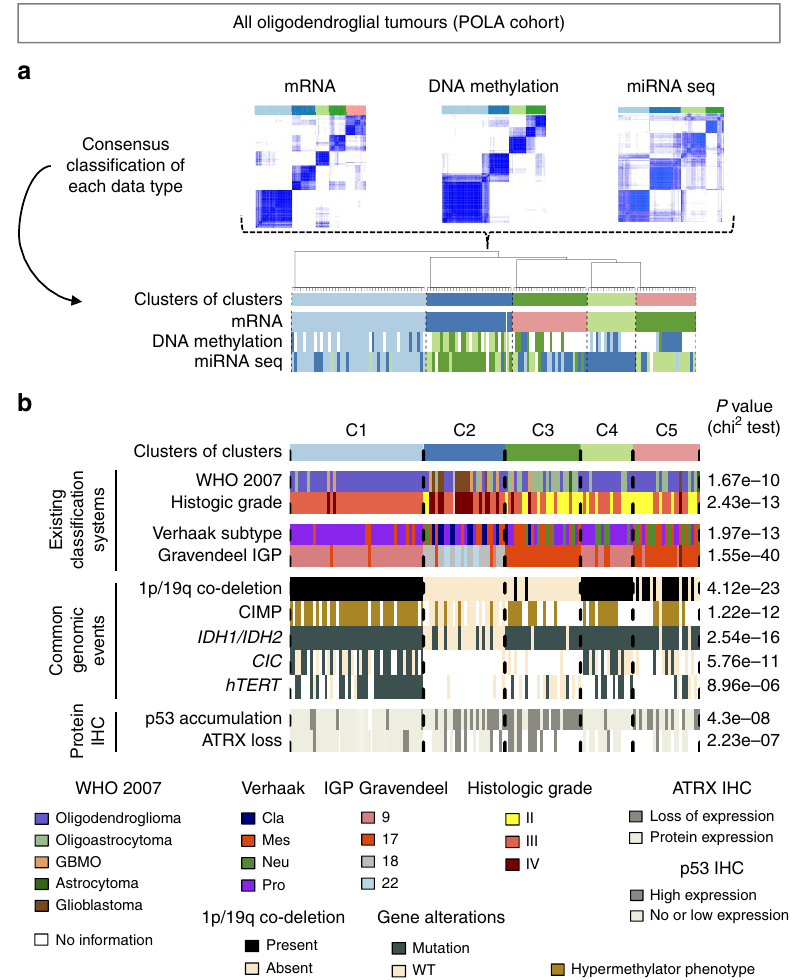
Figure 1 | Histo-molecular characterization of the five subtypes of oligodendroglial tumours robustly identified in POLA cohort. ( a ) An integrative ‘cluster of cluster’ approach was used to define robust molecular subtypes of 141 oligodendroglial tumours. Consensus clustering was used to assign molecular classes on the basis of mRNA data, DNA methylation data and microRNA data independently. Consensus ‘clusters of clusters’ were subsequently identified on the basis of the classes labels resulting from previous independent classifications. ( b ) Clinical annotations and common genomic alterations associated to each subtype. Genomic alterations were identified through the analysis of SNP arrays. For each clinical and molecular characteristic we performed w 2 tests to assess the strength of association with the five-class